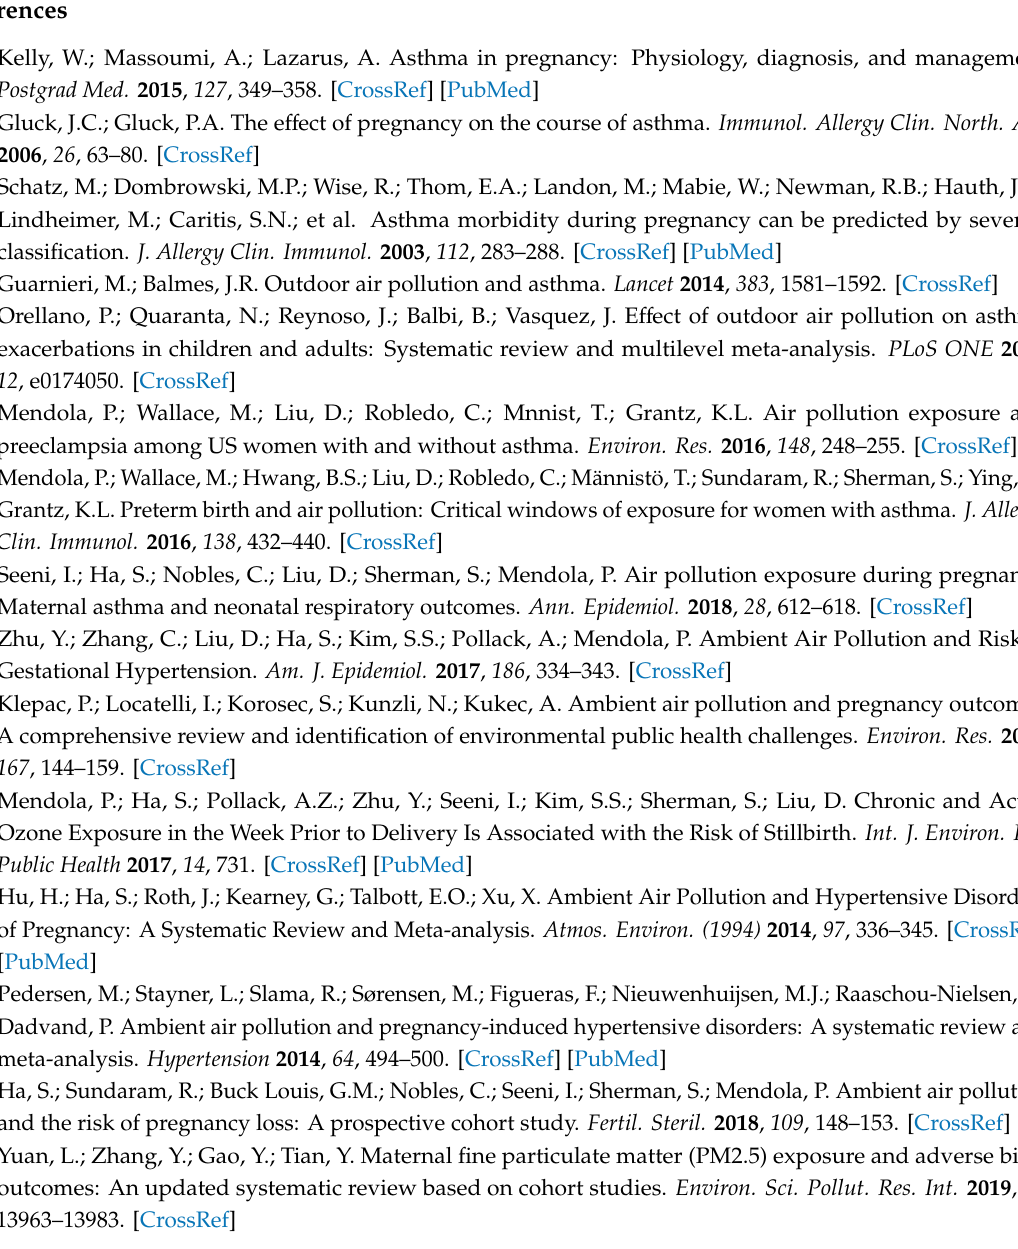
asthma status for Site 1; Table S4: Air pollution distribution by study site; Table S5: Correlation matrix for di ff erent pollutants across assessment